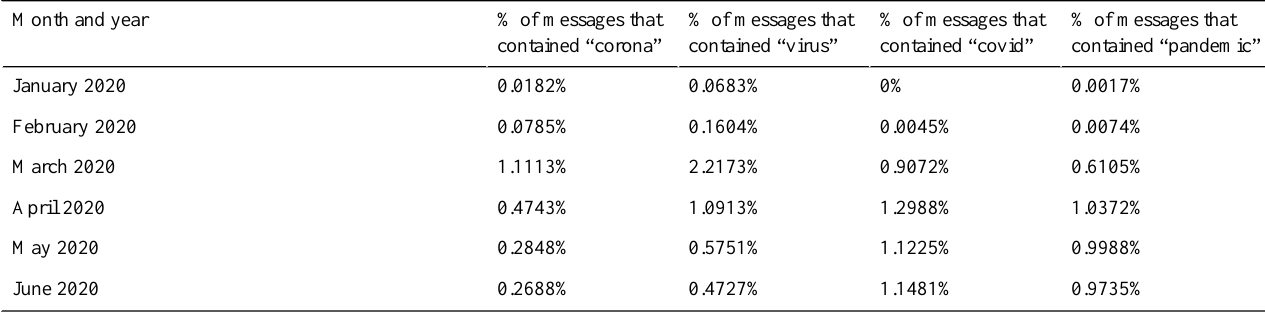
Table 1. Percentage of messages that contained pandemic-related seed words/regular expressions before and after the COVID-19 pandemic. “corona”Month and